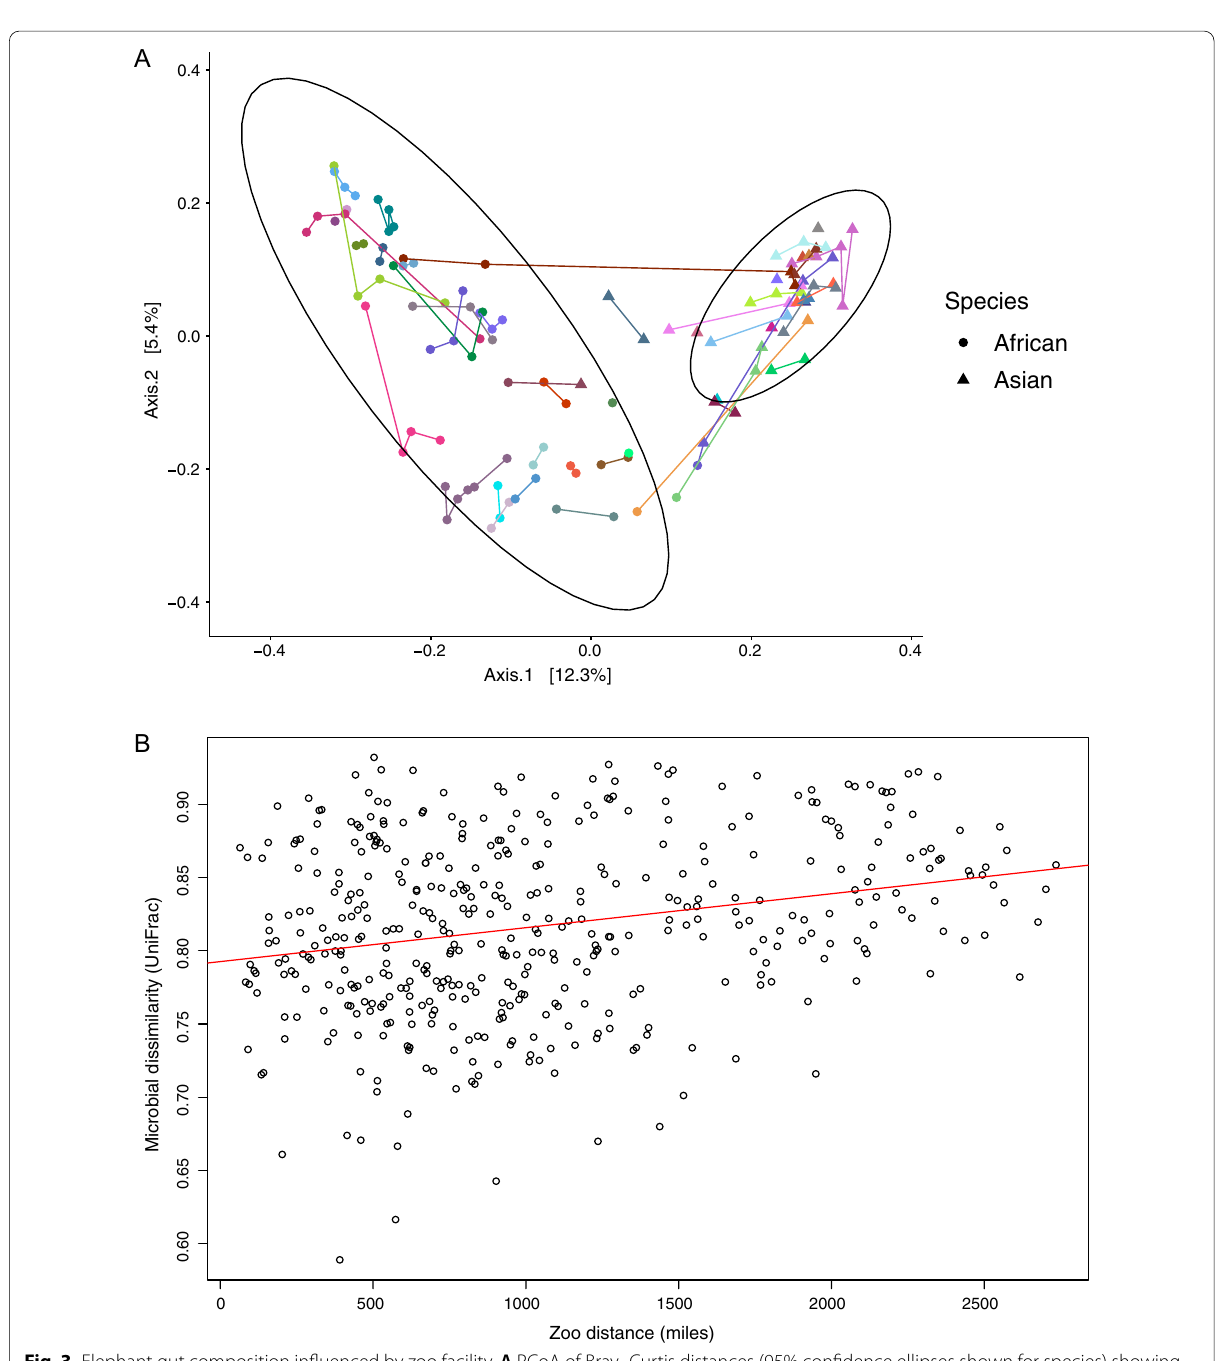
Fig. 3 Elephant gut composition influenced by zoo facility. A PCoA of Bray–Curtis distances (95% confidence ellipses shown for species) showing African and Asian elephant gut microbiome compositions with zoo facilities represented as unique colors with line linkages, and host species represented by shape (circle African elephant, triangle Asian elephant) (PERMANOVA p 0.001; zoo explained 65.15% variance). B African = = = elephant gut microbiomes are more similar among zoos near one another (Mantel test unweighted UniFrac p 0.0157, r = =